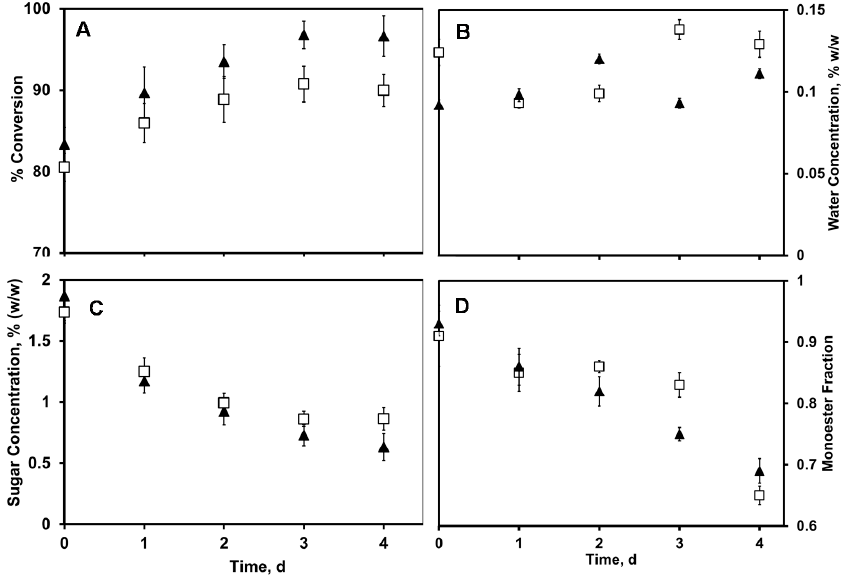
Figure 1. Time courses of the lipase-catalyzed synthesis of fructose oleate (triangle) and sucrose oleate (square): ( A ) conversion of oleic acid; ( B ) water concentration; ( C ) saccharide concentration; and ( D )